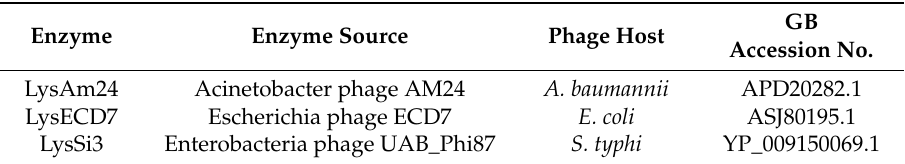
Table 2. Endolysins used in the